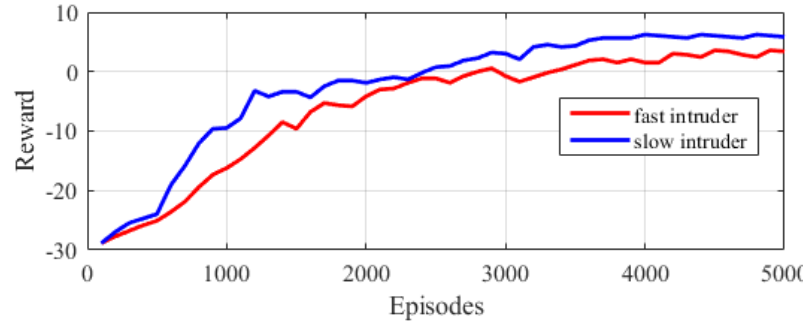
Figure 6. Average episode rewards for two USVs and one intruder.